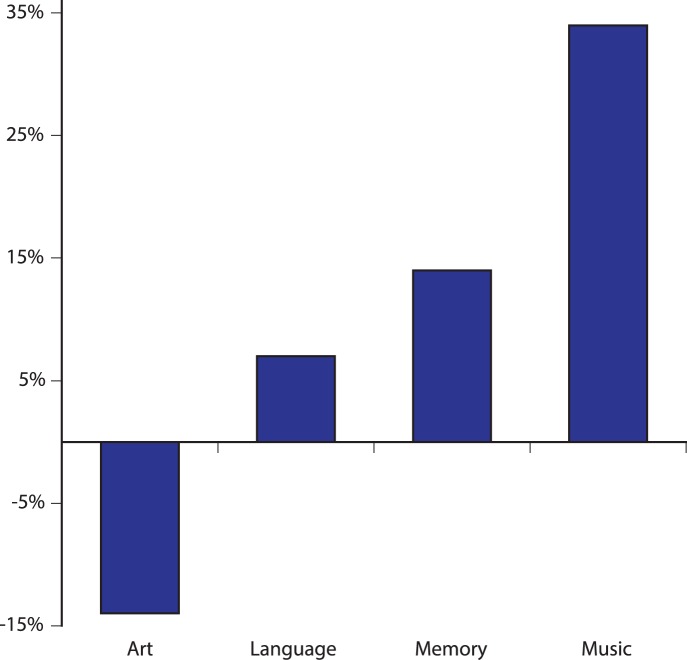
Percentage increase in publications from 2005 to 2011.Source is Web of Science. Number of publications across the time period is higher for language (539 to 817) and memory (1,140 to 2,031) than for music (81 to 162), but growth is faster in the music domain. As shown by the decrease in art-related publications, the increase in music publication is not due to a general increase in scientific publications relating to the arts.